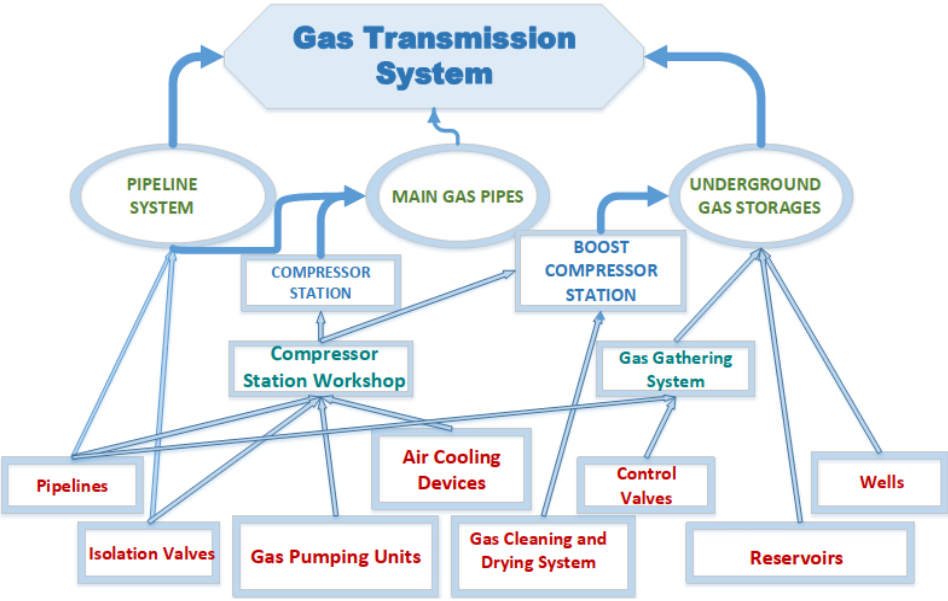
Figure 3. Underground gas storage facilities in the structure of the gas transmission system. For all UGS facilities, we developed their information models, as well as software for representation of the piping and instrumentation diagram of UGS in terms of the theory of graphs (Figure 4).